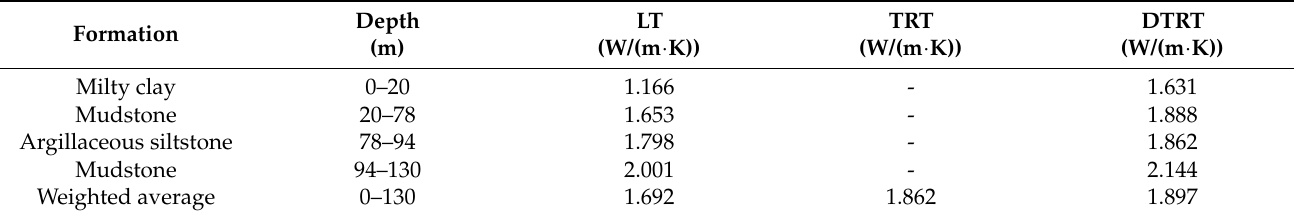
Table 6. Results of three test